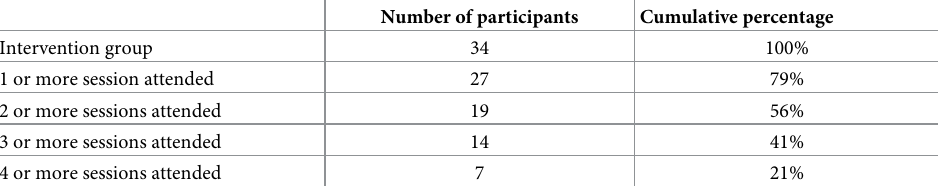
Table 4. Number of MI sessions attended.